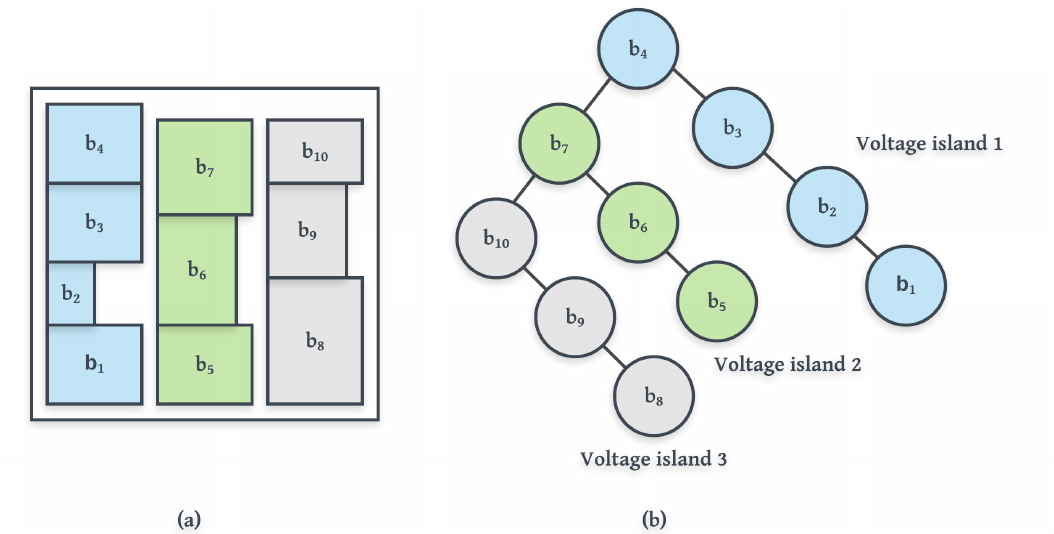
Figure 3. Example floorplan. ( a ) Floorplan after application of SKB tree ( b ) SKB tree structure of the